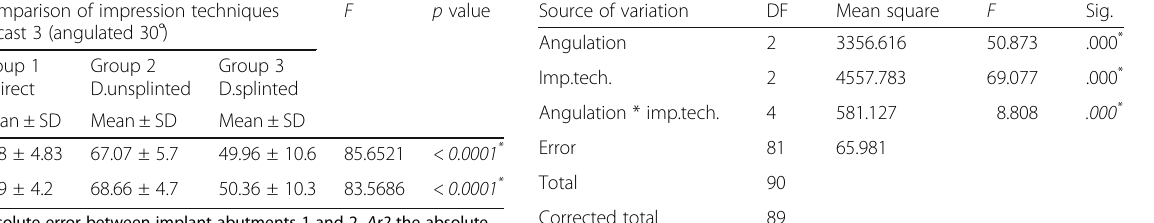
Table 4 Comparison of impression techniques in cast 3 using one-way ANOVA Comparison of impression techniques in cast 3 (angulated 30 ৹ )